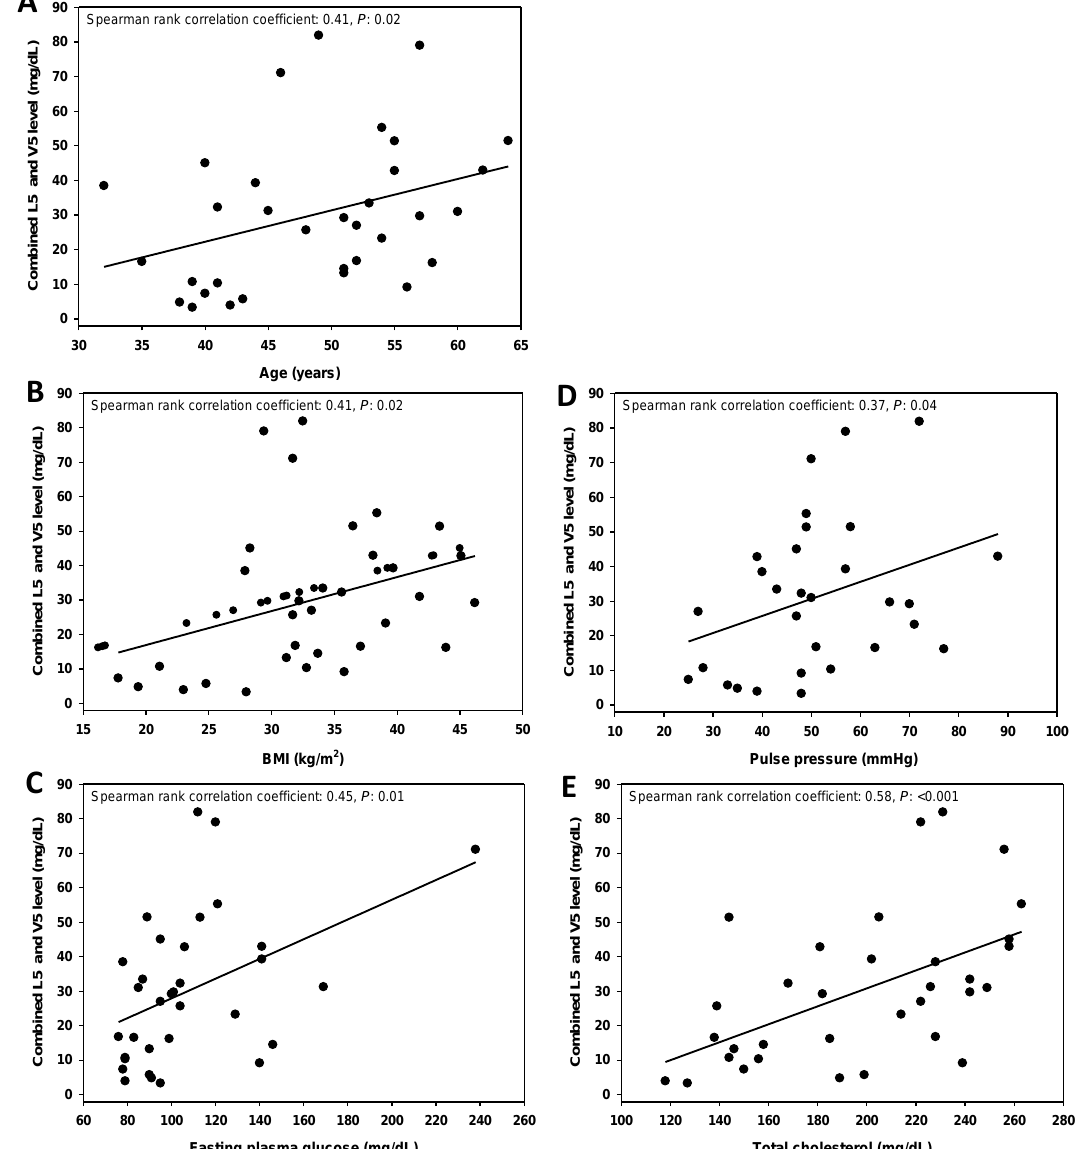
Figure 3. Correlation between combined L5 and V5 levels and select coronary heart disease (CHD) risk factors ( n = 33). The combined L5 and V5 values were plotted against age ( A ), body mass index (BMI) ( B ), fasting plasma glucose level ( C ), pulse pressure ( D ), and total cholesterol level ( E ).